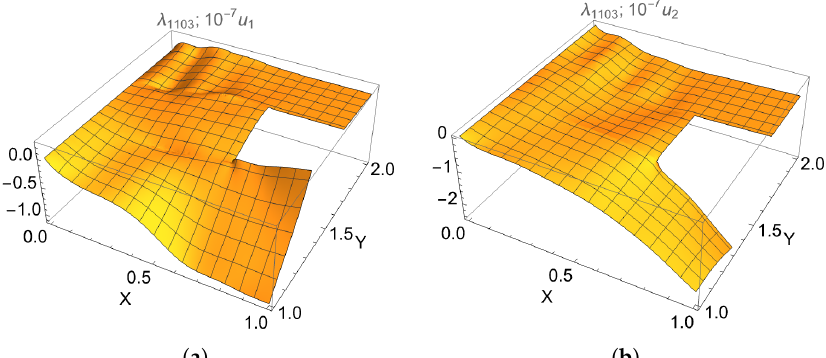
Figure 8. Three regions of uncertain materials. Visualization of the Legendre coefficients of the stochastic modes with the smallest pseudoenergies, λ 1103 = ( L 1 that the mode was selected as the 1103th; ( a ) λ 1103 ( u 1 ) and ( b ) λ 1103 ( u 2 ) .